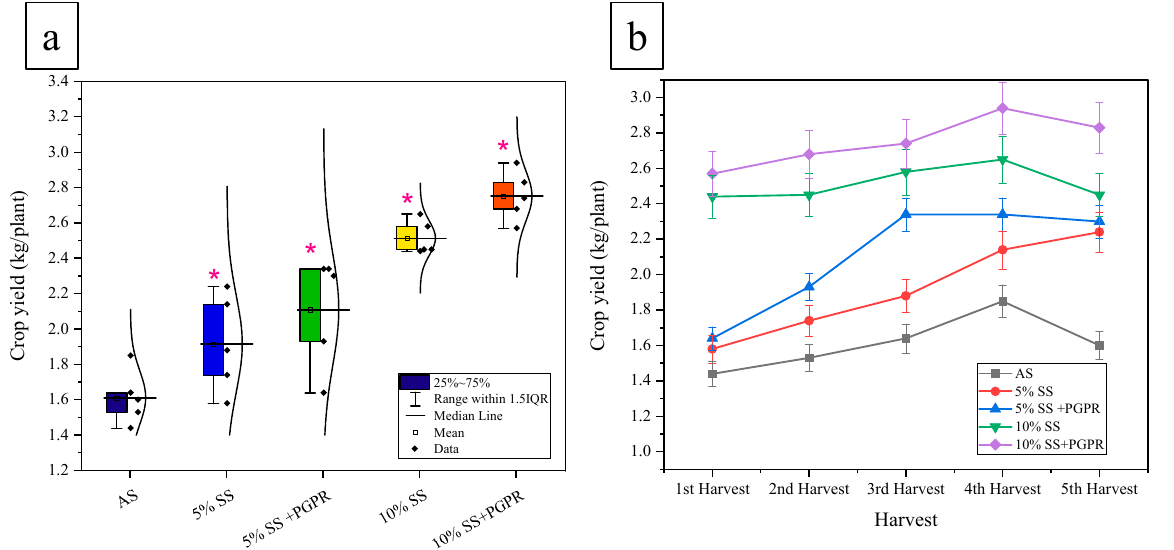
Figure 5. Effect of sewage sludge (SS) and plant growth-promoting rhizobia (PGPR) amendment on ( a ) total and ( b ) per harvest crop yield of Ridge gourd ( L. acutangula ); * indicates significantly different from AS as control group.